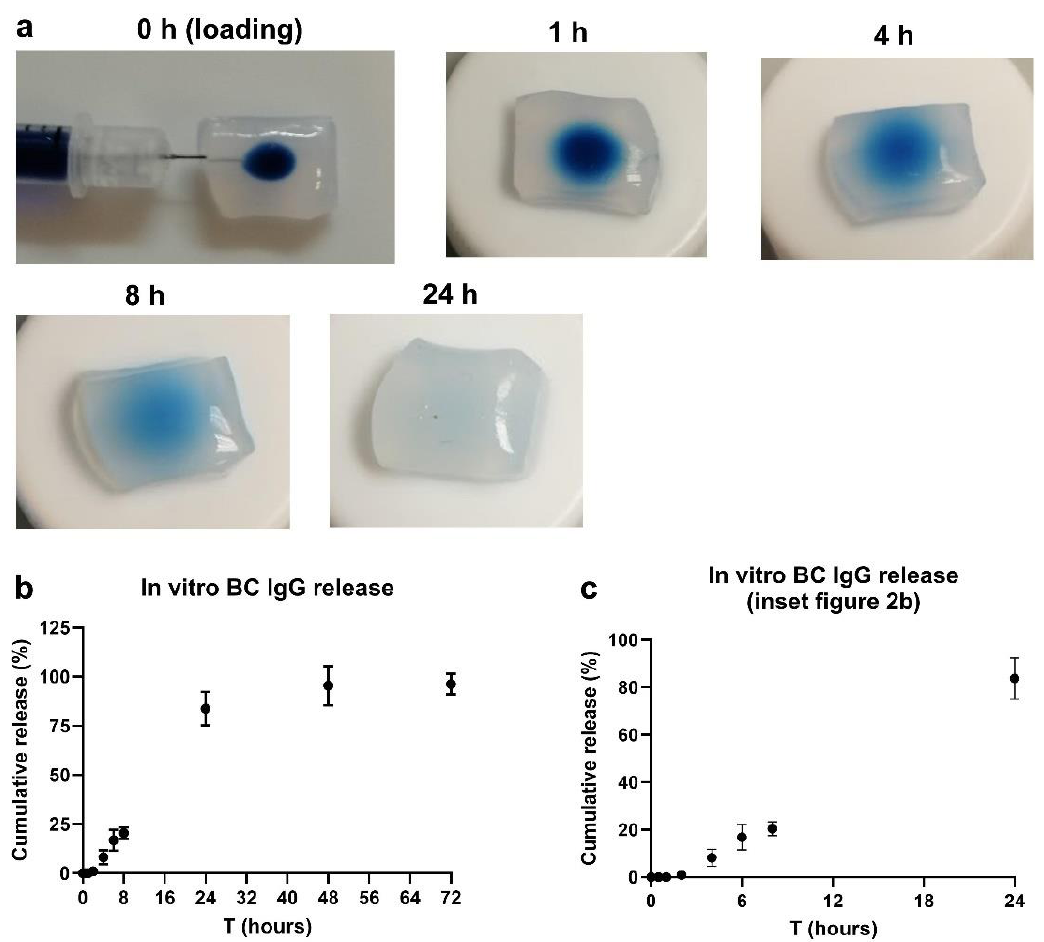
Figure 2. Human IgG loading and in vitro release were performed with the ‘injection method’. ( a ) A total of 50 µ g IgG in a volume of 25 µ L PBS was injected into the center of a BC fleece. To visualize the injection depot, the IgG solution was supplied with Trypan blue. The loaded fleeces were then put in blocking buffer (1% BSA/0.05% Tween-20 in PBS) and IgG release was followed. At several time-points, the fleeces were taken out, and the Trypan blue injection spots were photographed. Graph ( b ) shows the cumulative IgG release in %, with the inset of the first 24 h shown in ( c ). Release data are shown as cumulative release, which are displayed as mean ± SD for a triplicate